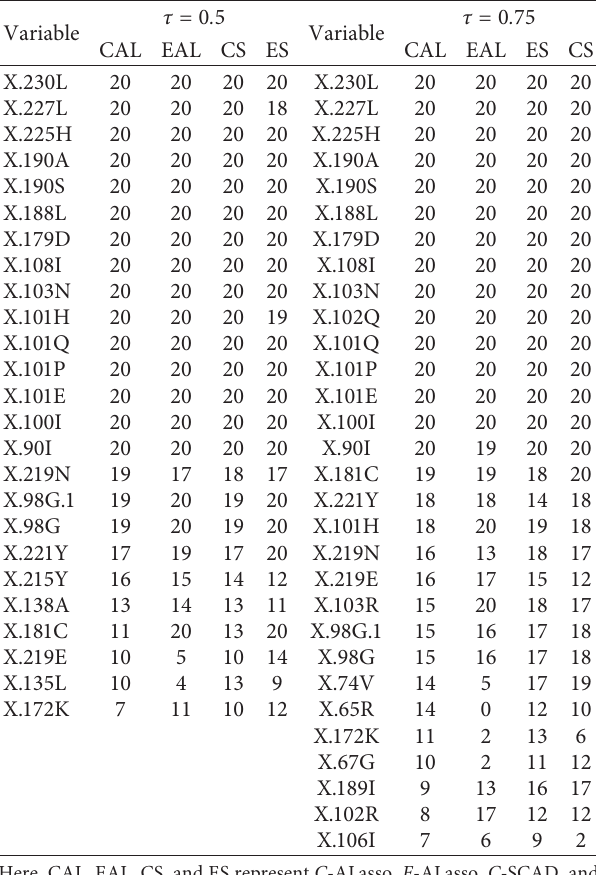
Table 4: Frequency table for the HIV